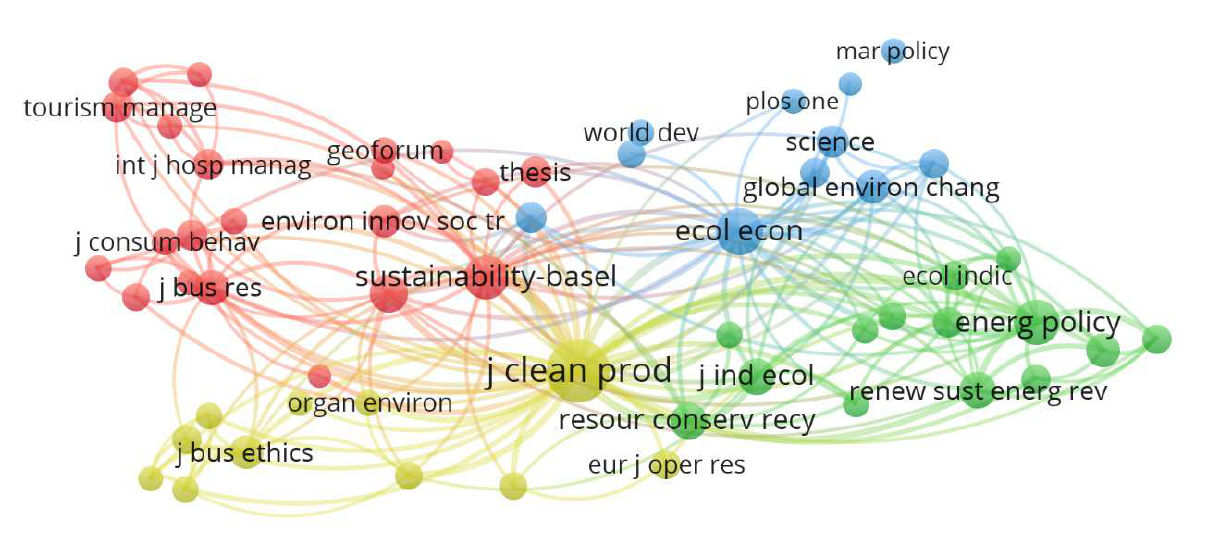
Figure 5. Co-citation map of academic journals related to this study